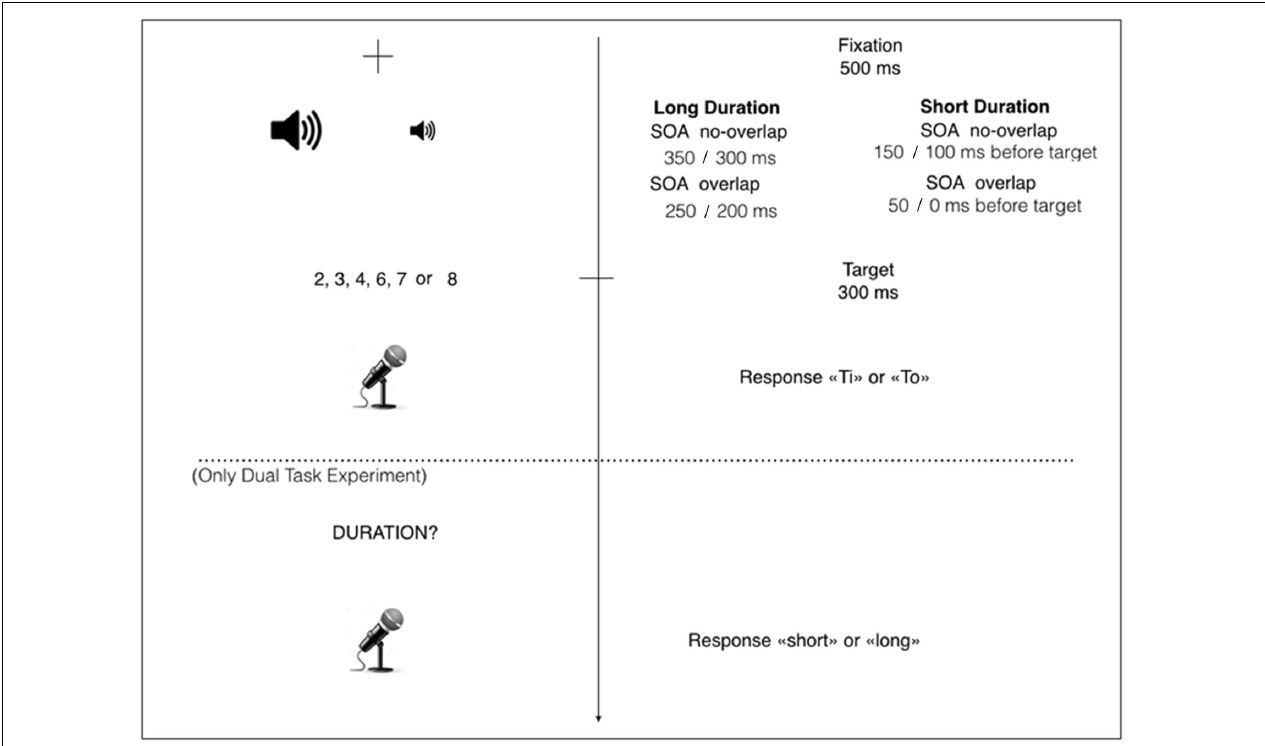
FIGURE 1 | Stimuli presentation. Each trial started with the presentation of the fixation cross for 500 ms. Immediately after, the auditory cue was presented, that could be short (100 or 150 ms) or long (300 or 350 ms). The auditory cue could overlap with the target for 100 ms (overlap conditions) or not (no-overlap conditions). At 100 ms before the tone’s offset (overlap conditions) or at the same time as the tone’s offset (no-overlap conditions), the Arabic digit was presented for 300 ms. As soon as the Arabic digit appeared, participants had to answer, as quickly and accurately as possible, if the number was smaller or larger than 5, by saying the non-words “Ti” and “To” (response pattern counterbalanced between participants). After that, only the participants assigned to the Dual Task condition had to report if the tone was short or long, by saying the words “short” and “long,” at the appearance of the word